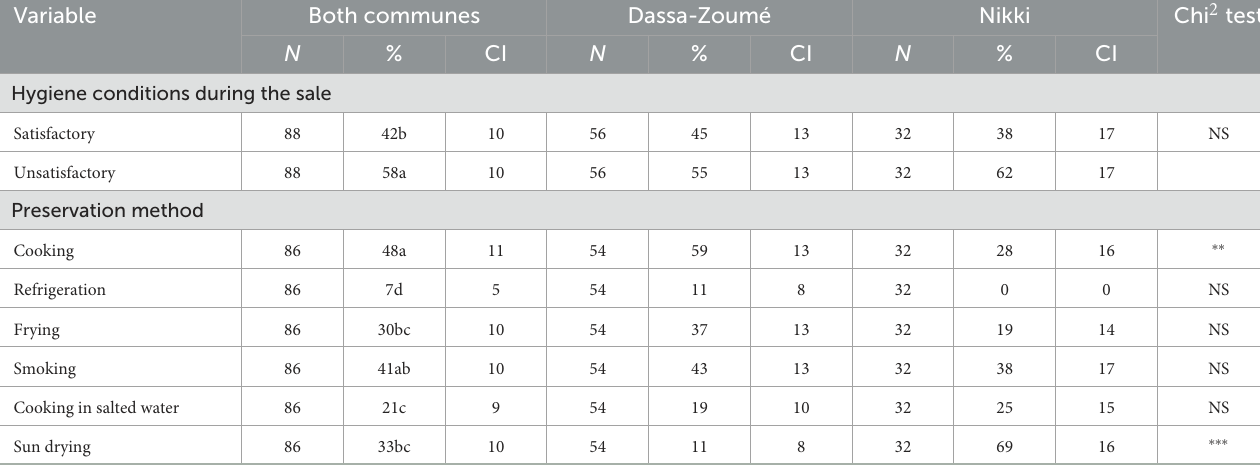
TABLE 7 Consumer assessment of hygiene conditions at the time of sale and preservation methods. Variable Both